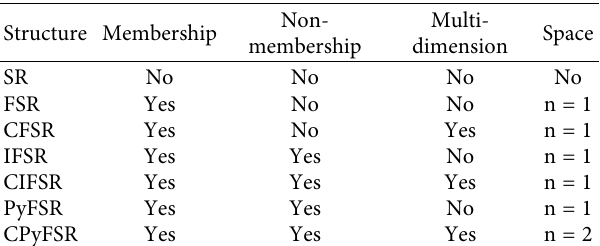
Table 7: Summary of comparative analysis based on the